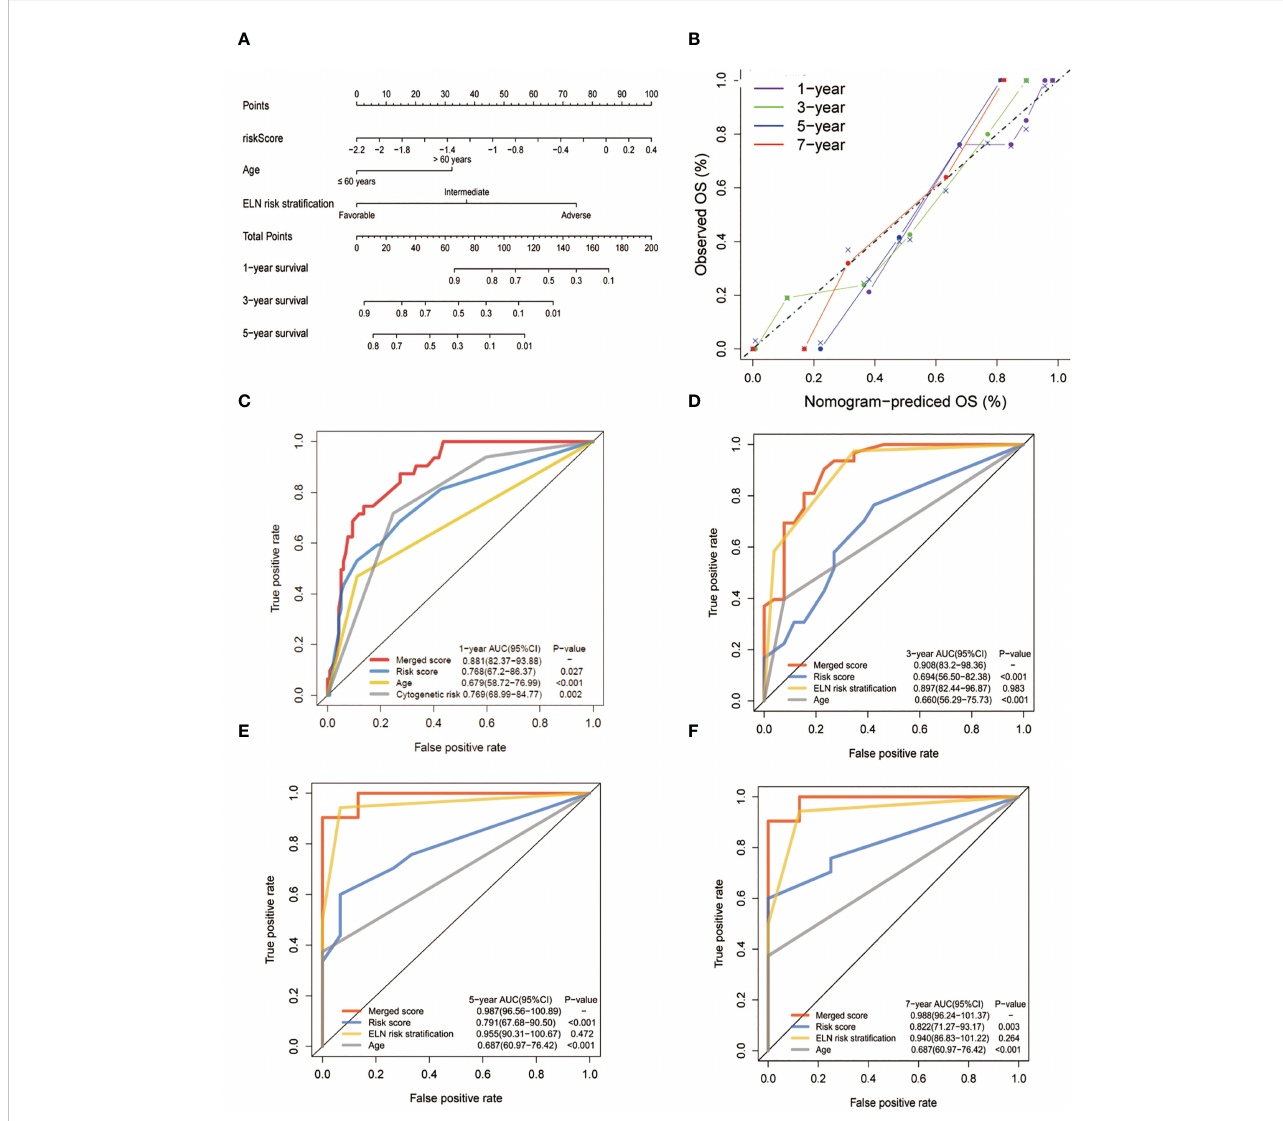
FIGURE 6 Construction and validation of the nomogram for prediction of OS in patients with AML. (A) The nomogram plot was constructed based on the lipid risk score and the 2017 ELN cytogenetic risk classi fi cation. (B) Calibration plot of the nomogram. (C-F) AUCs of one-,three-, fi ve-, and seven-year OS. The lipid pro fi le risk score showed greater predictive accuracy than the 2017 ELN classi fi cation for one-year OS while the merged model showed greater predictive accuracy for all observed